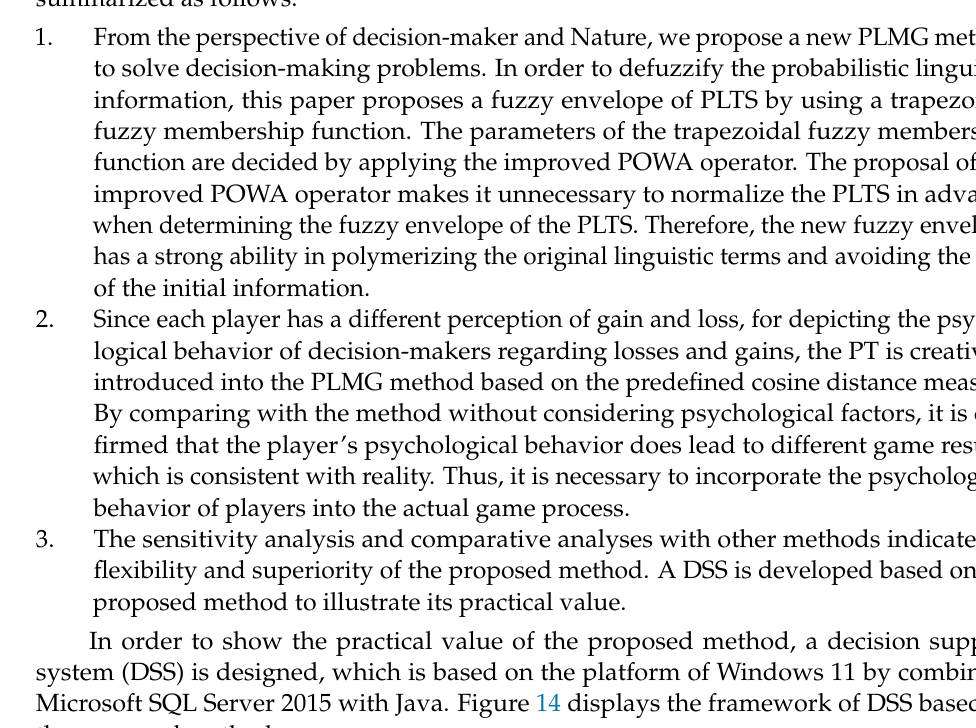
Figure 15. Main interfaces of results obtained by the proposed method. Remark 3. According to the DSS designed above, the decision-maker can quickly obtain the optimal strate- gy only by inputting the numbers of pure strategies for players, the payoff values expressed by trapezoidal membership function, double reference points and the risk attitude parameter. Thus, the process of the pro- posed method can be simplified by using the DSS. The proposed method not only narrows the theoretical gap of matrix games in the con- text of probabilistic linguistic, but also has important practical value. Different from other